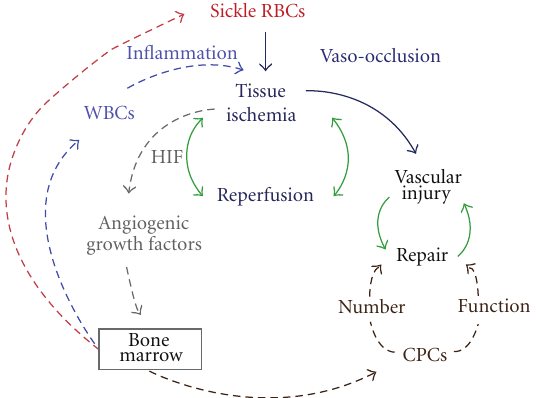
Figure 3: Diagram of CPC and WBC mobilization by vaso- occlusion induced tissue ischemia. Vaso-occlusion by sickled red blood cells (RBCs, red) results in tissue ischemia and reperfusion (navy blue). Repeated episodes of vascular ischemia are likely to promote vessel injury (black). Green arrows depict balanced physiologic processes that aim to restore equilibrium. Hypoxia- inducible factor (HIF, gray) produced by ischemic tissues stimulates angiogenic growth factors and bone marrow mobilization of angio- genic progenitor cells (CPCs, brown) that participate in vascular repair, white blood cells (light blue) that promote inflammation, and more sickle red blood